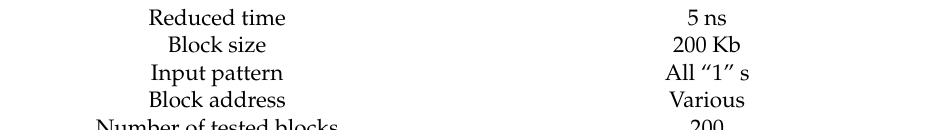
Table 1. Experimental parameters used for t RCD and t RP reduction-based DRAM PUFs.